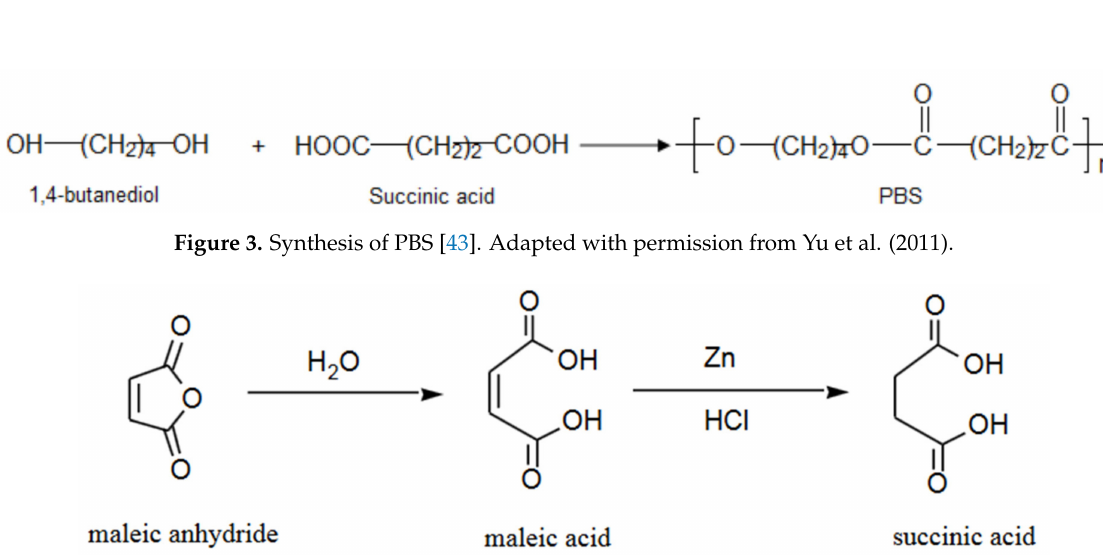
Figure 4. Reaction of maleic anhydride to succinic acid [45]. Adapted with permission from A δαµ o π o´ υ λ o υ (2013).